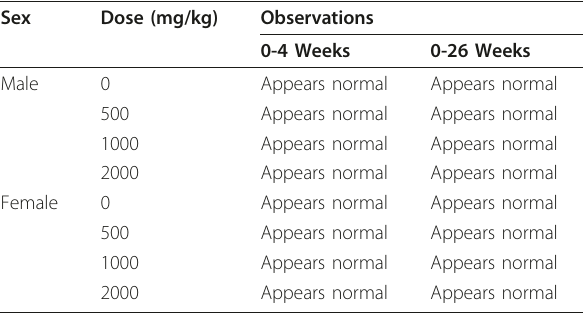
Table 2 Abnormal clinical signs and mortality in rats orally treated with